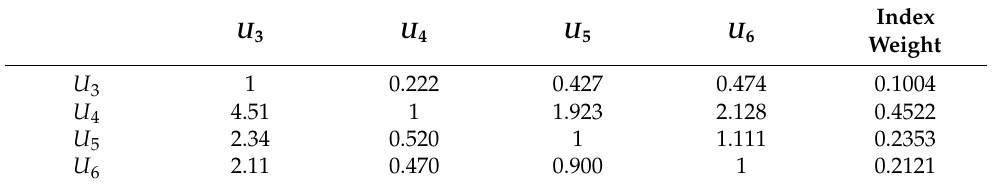
Table 15. Index weight calculation of adverse